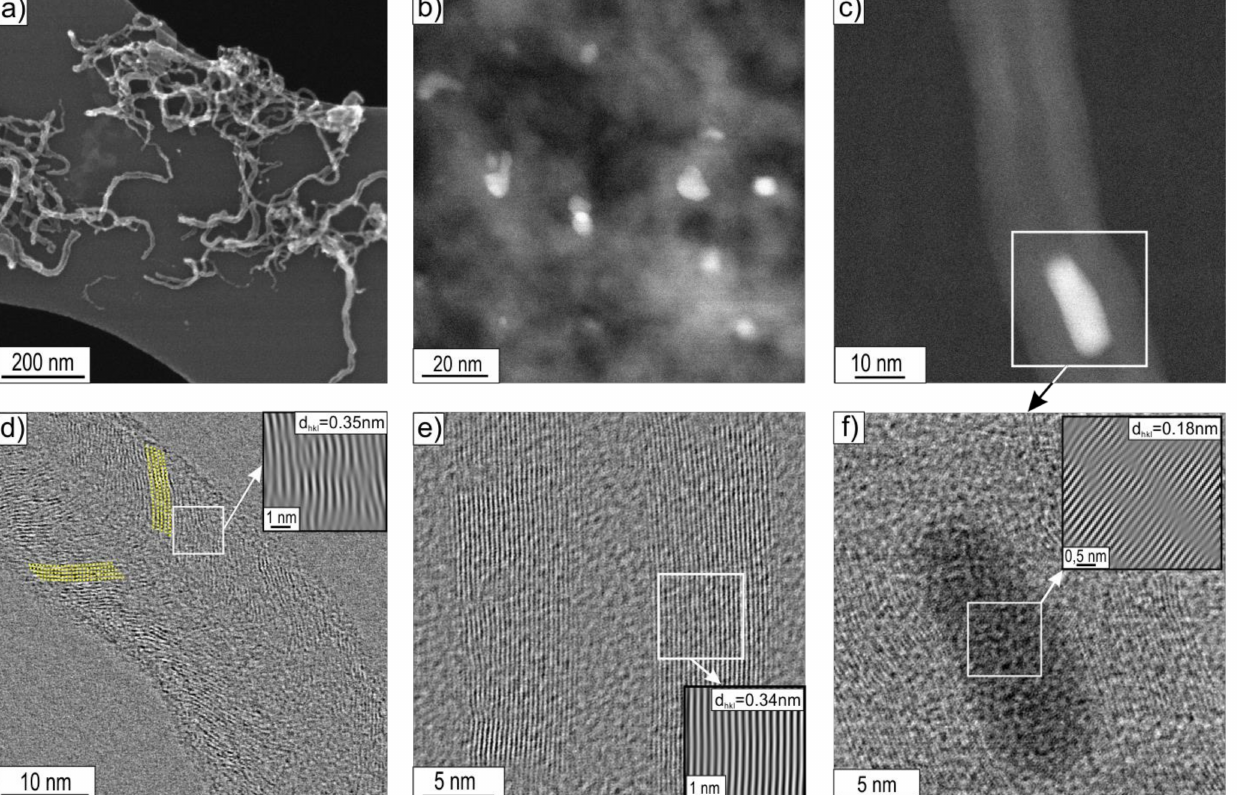
Figure 11. STEM morphology of deposit formed on the Ni 3 Al foils’ surface after decomposition of ethanol with 1.1 vol.% water steam (mixture #3) at 700 ◦ C: ( a,b ) general view and area of: ( c ) multiwalled carbon nanotube with inside Ni particle, ( d ) herringbone type multiwalled carbon nanotubes, ( e ) multiwalled carbon nanotube, and ( f ) Ni particle inside MWCNT ( a —SE mode; b , c —HAADF mode; d – f —BF mode with the enlarged areas performed using